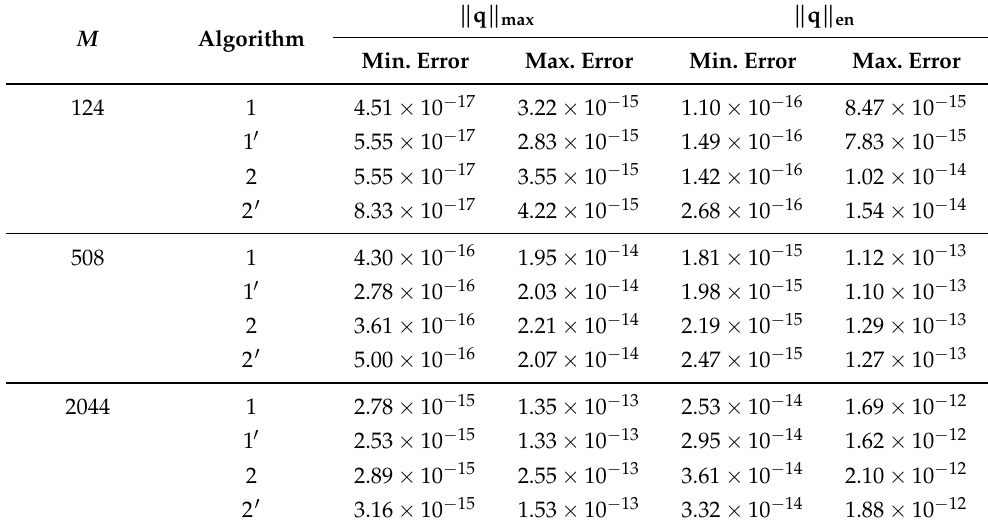
Table 3. Minimum and maximum error norms detected among solutions to 10 6 test problems (20a) by the four algorithms.